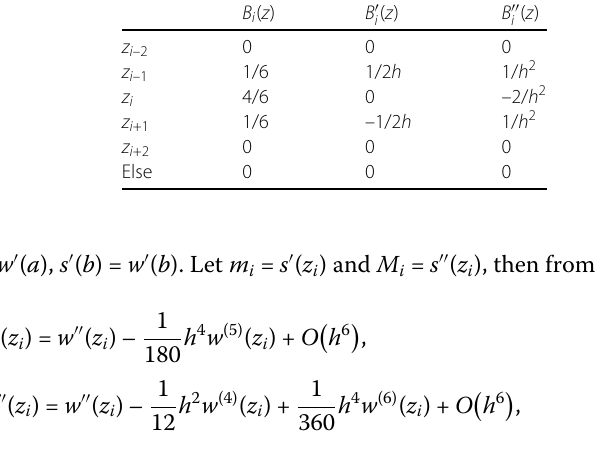
( z ), and B (cid:3)(cid:3) ( z ) at the knots i i B i ( z ) B (cid:3) i ( z ) B (cid:3)(cid:3) i ( z ) z i